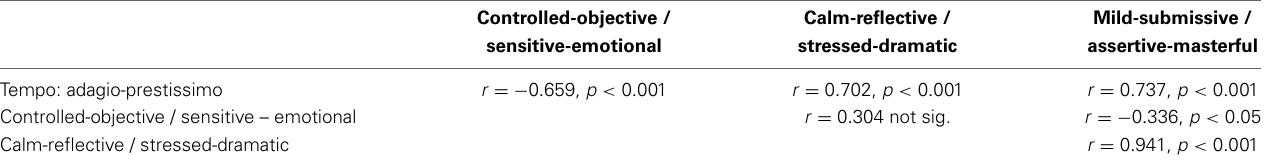
Table 2 | Correlations evident among ratings for the four music characteristics’